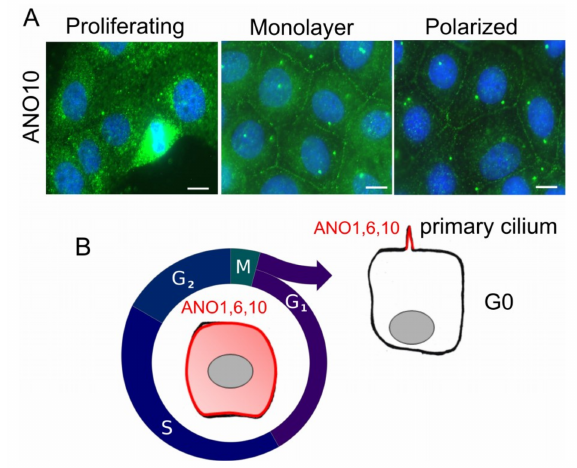
Figure 1. Proliferation-dependent expression of ANO10 in FRT cells. ( A ) FRT cells were grown in FCS-containing media at 70% density (Proliferating), as confluent monolayer in FCS-free media (Monolayer), or as polarized monolayer on permeable supports and in FCS-free media (Polarized). Expression of endogenous ANO10 (green fluorescence) was intracellular in dividing cells (Proliferating), but was detected in the plasma membrane and in the primary cilium in densely grown cells (Monolayer). ANO10 was more prominent in plasma membrane and primary cilium in polarized cells (Polarized). For further details and references, see main text. ( B ) Hypothetical model proposing variable cellular locations of ANO10 depending on cell proliferation or cell polarization. ANO10 is found primarily intracellularly, but is also in the plasma membrane during cell cycle. Reduced expression of ANO10 and translocation into the primary cilium is observed once cells move into G 0 . Bar, 20 µ m